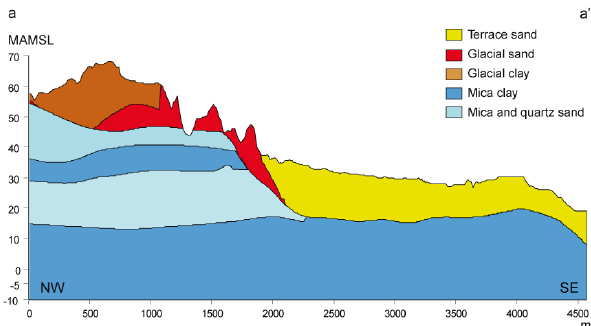
Fig. 2. Geological cross section along the planned motorway. Cross Fig. 2 Geological cross section along the planned motorway. Cross section is along projected motorway (a-a’) 3 section is along projected motorway (a-a 0 ) shown in Fig. 1. Up- shown in Fig. 1. Upper and lower mica sand is termed Mica sand 1 and Mica sand 2, respectively (Individual 4 parameters are found for these two units during model calibration, described later). 5 per and lower mica sand are termed Mica sand 1 and Mica sand 6 2, respectively (individual parameters are found for these two units during model calibration, described